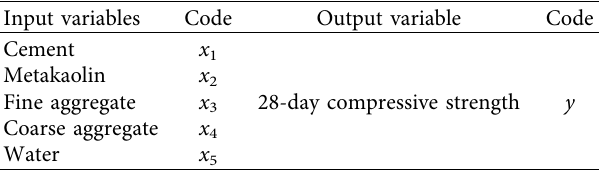
Table 4: Design variables for the concrete mix.